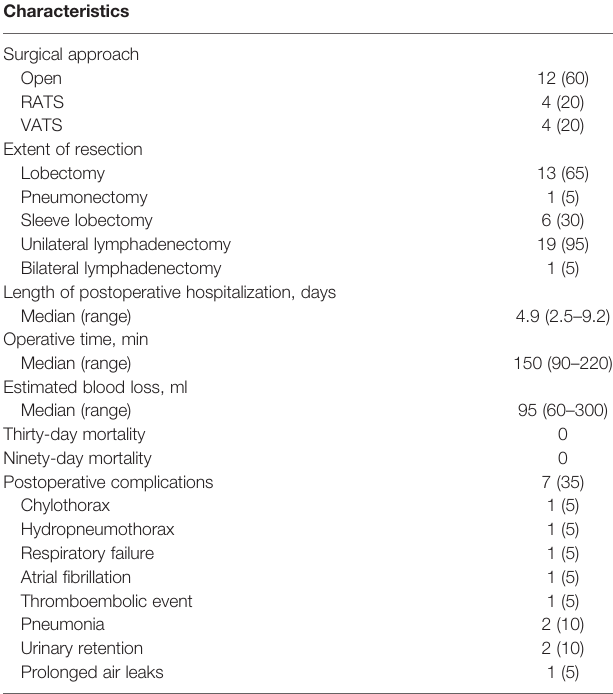
Data are given as number (percentage) unless otherwise